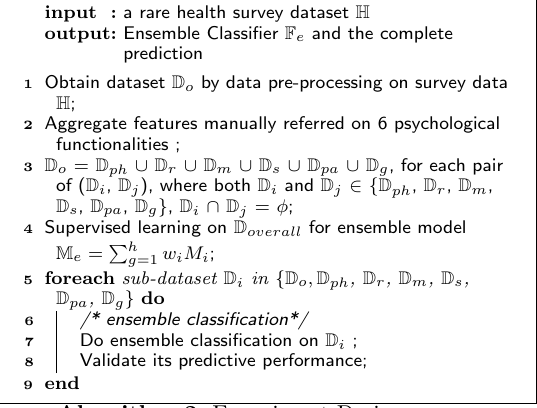
Algorithm 2: Experiment Design